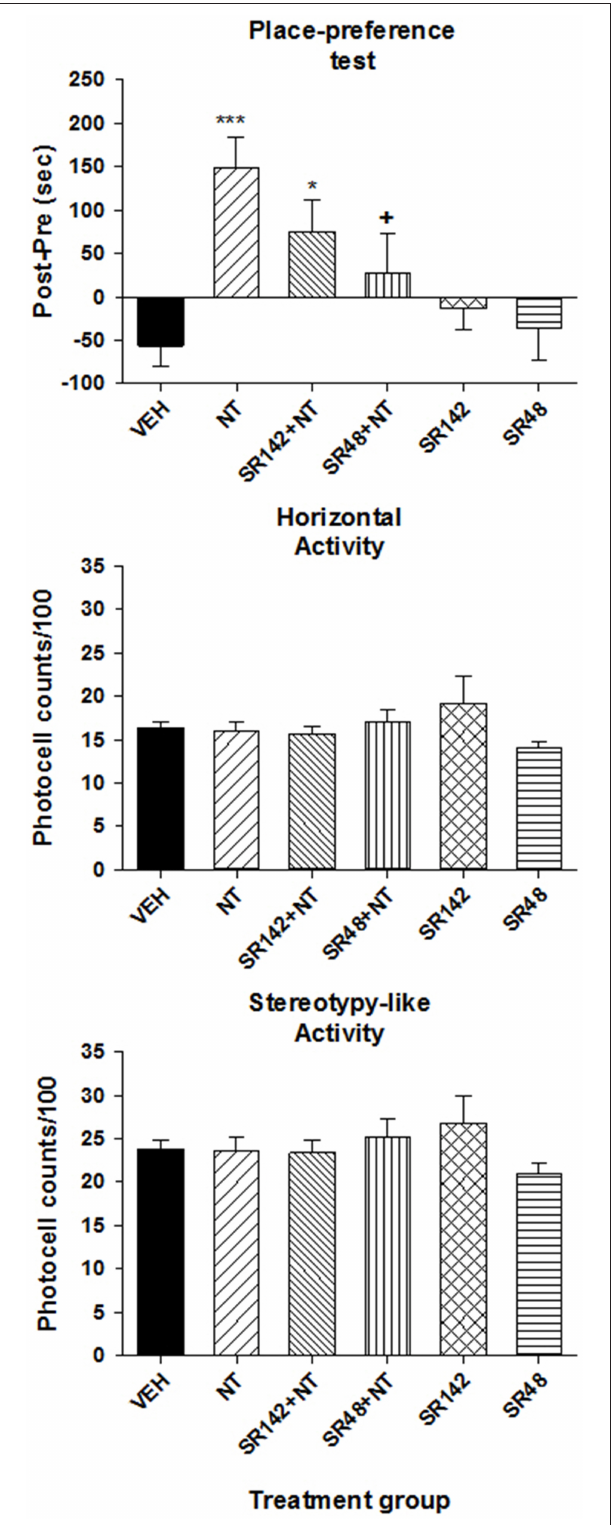
FIGURE 3 | Effects of SR142948 and SR48692 on [D-Tyr 11 ]NT-induced CPP. Top panel illustrates the preference score measured on the test day